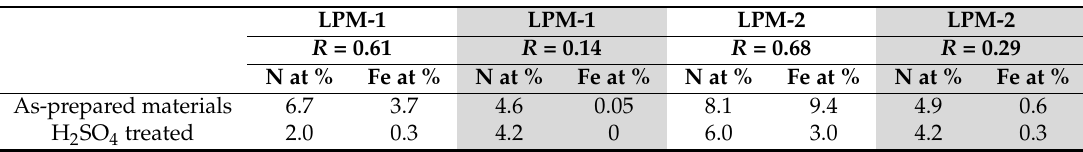
Table 1. XPS nitrogen and iron content for materials prepared from FeOOH (LMP-1) and Fe(acac) 3 (LMP-2) for high (white areas) and low (grey areas) R